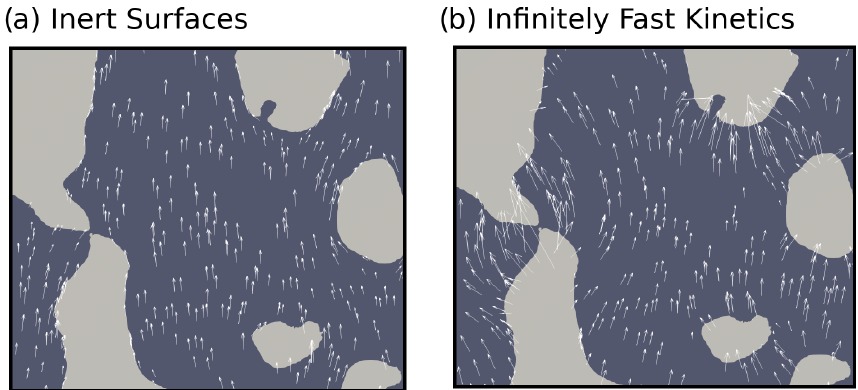
Figure 5. Vapor streamlines inside the melt form sample for a temperature gradient of 50Km − 1 and the inert-surface and infinitely fast kinetics cases. Note that the arrows showing the vapor flux are centered around the point they represent and might therefore wrongly appear to originate from or terminate in the